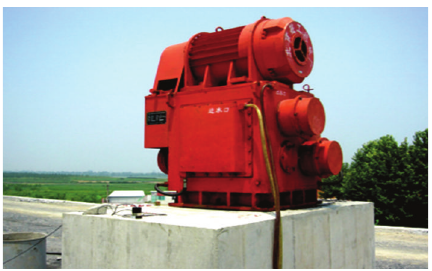
Figure 2: Platform of the repeated impact test conducted by Japan Railway’s Railway Technical Research Institute.